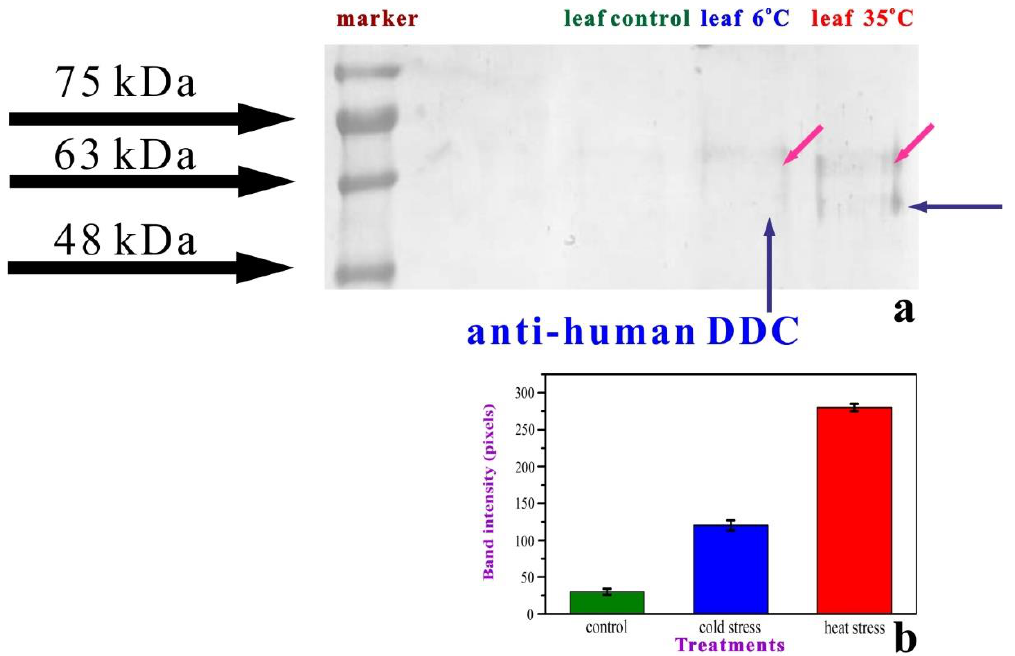
Figure 5. The immunodetection of DDC ( a ) and bar graph for the quantification of the band intensity ( b ) in the leaf samples of control and exposed plants (small blue arrows). The upper band (pink arrows) probably indicates a weak expression of another transcript of the DDC, with an approximately similar molecular weight.